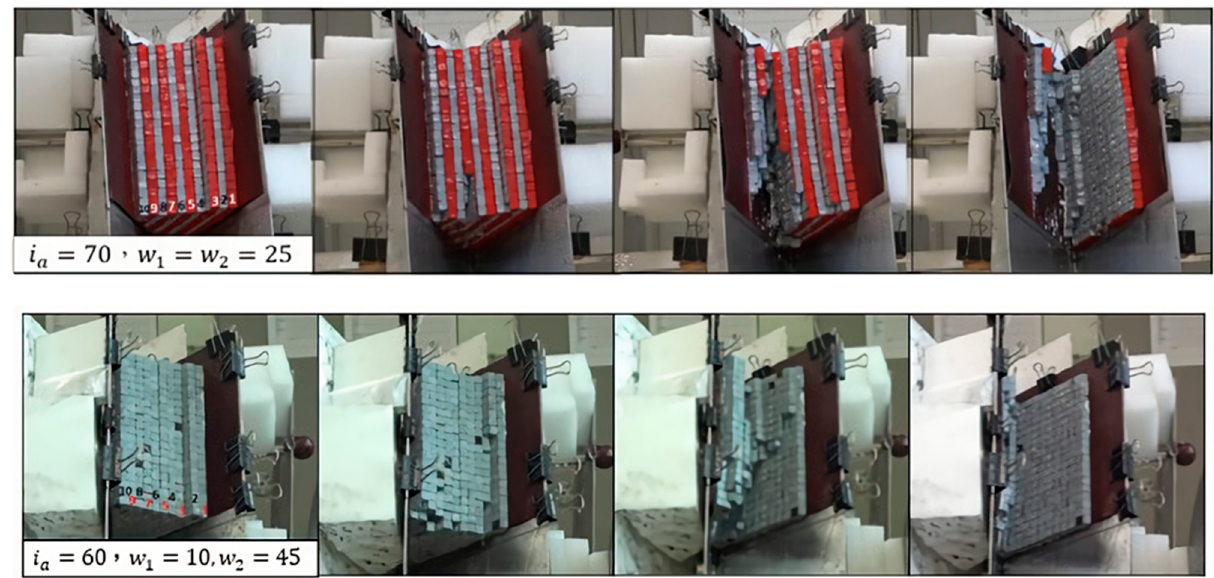
Figure 17. Comparison of tests with ω 1 ≠ω 2.